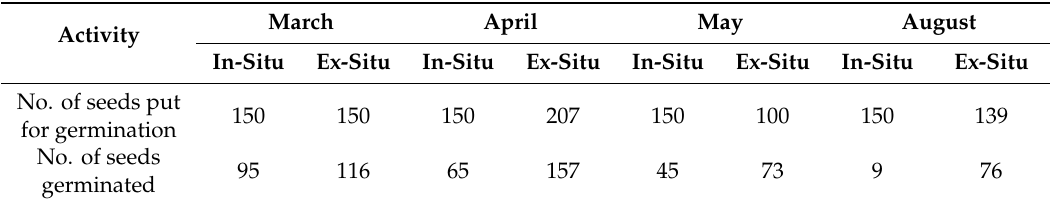
Table 3. Seed germination in in-situ and ex-situ